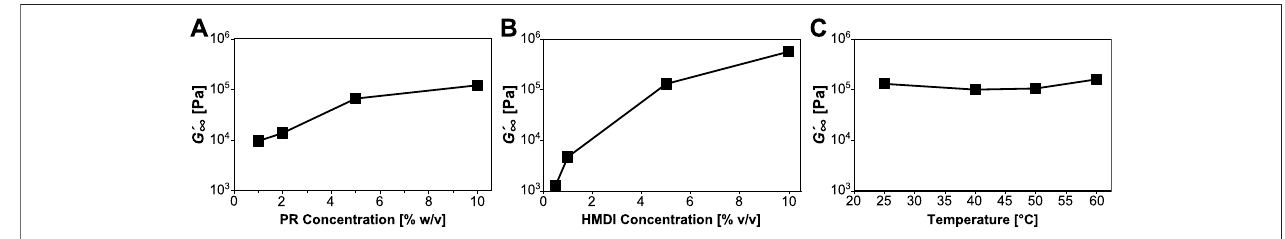
FIGURE 3 | Post-gelation mechanics of slide-ring gels. Plateau modulus ( G ∞ ′ ) , which serves as a proxy for mechanical properties after completion of gelation, is plotted against (A) PR concentration (B) cross-linker concentration and (C) temperature. Concentration of HMDI, which dictates the formation of elastically effective crosslinks, has a signi fi cantly higher impact on G ∞ ′ than temperature and PR concentration.